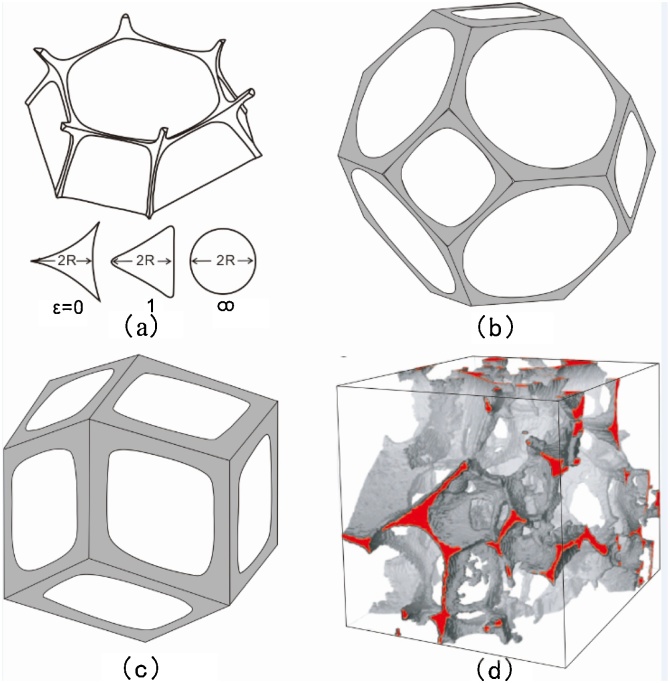
Common pore geometry models (a, b, c) and three-dimensional melt distribution (d) [16,17].